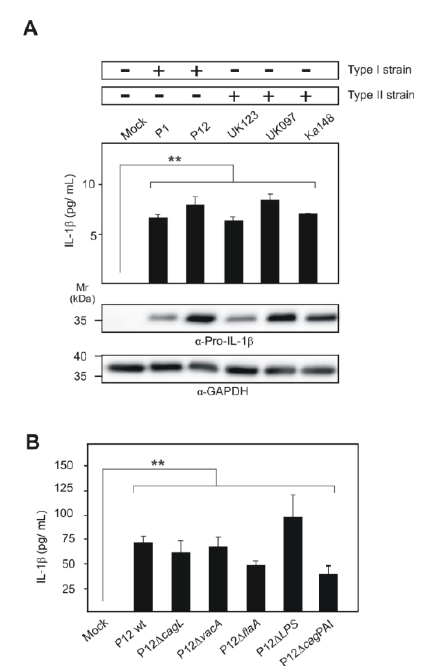
Figure 1. Induced expression of pro-IL-1 β in H. pylori -infected THP1 monocytes. The first signal of NLRP3 inflammasome activation requires the optimal production of inflammasome components including pro-IL-1β, which is not generally expressed in immune cells without induction. Different wild-type strains including type-I and type-II H. pylori were infected for 6 h to analyze the pro-IL-1 β expression and secretion ( A ). Furthermore, H. pylori P12 wild-type and isogenic mutants were also used to identify the effect on secretion at 24 h of infection with THP1 monocytes ( B ). GAPDH protein immunoblots were used as loading reference. ** p ≤ 0.01